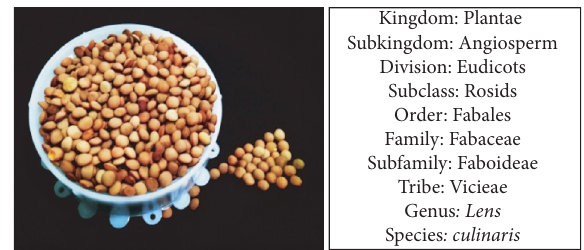
Figure 2: A photo (in the left side) and taxonomic description (in the right side) of lentils. Table 1: Global lentil production in 2019